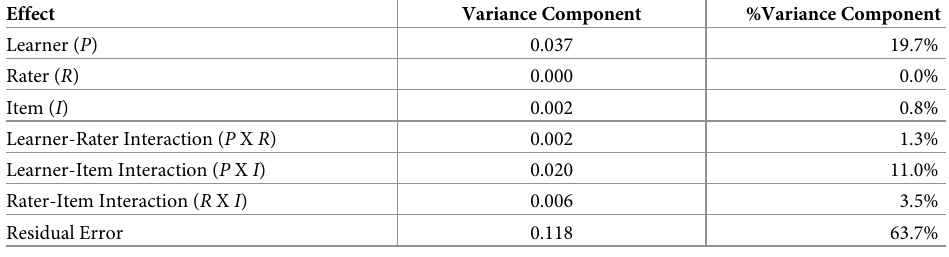
Table 3. Generalizability study results from the 2018 and 2019